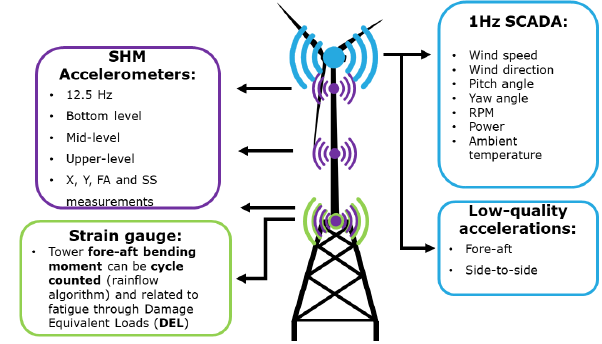
Figure 2. Overview of different sensors installed in wind turbine. Sensors locations are not accurate representations.